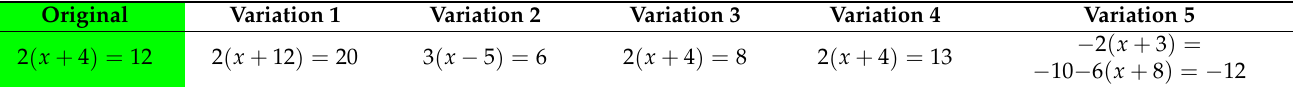
Table 9. Examples of type 8 equations and variations.